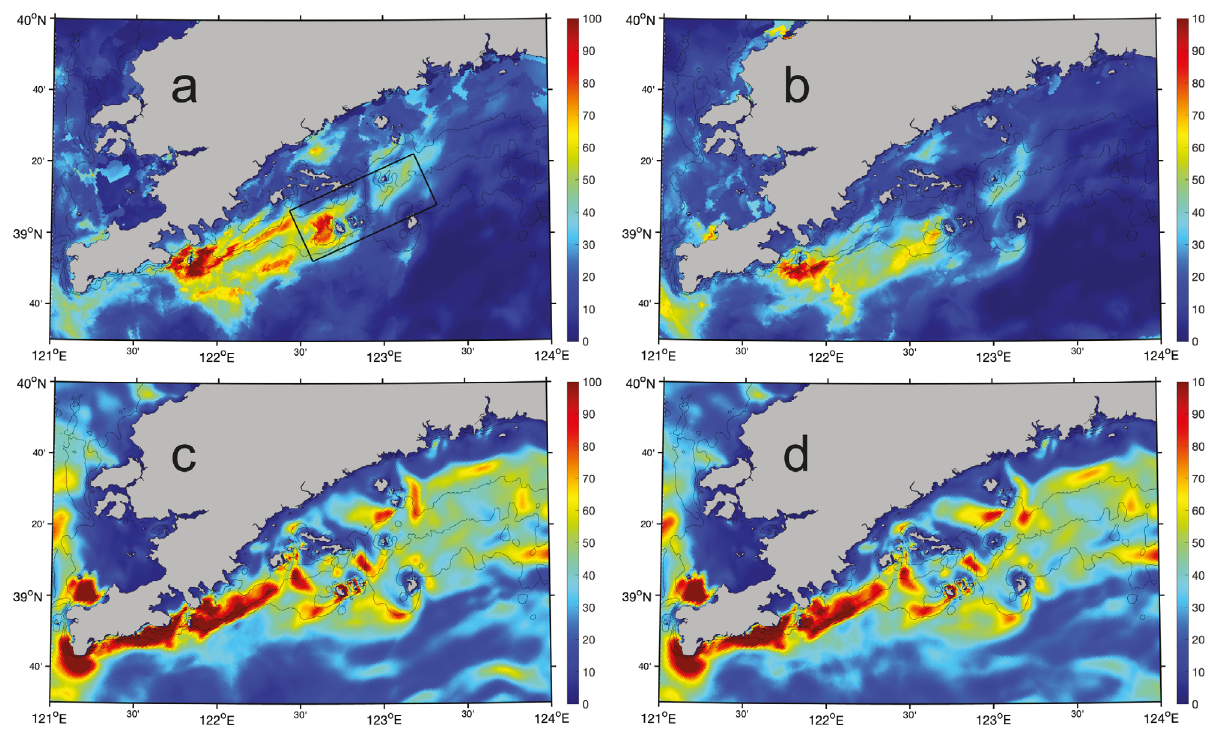
Fig. 8. Geographical distribution of the ‘dt*days’ index for the period 1 July to 30 September in (a,c) 2014 or (b,d) 2015, based on (a,b) low-passed bottom temperature time series or (c,d) original bottom temperature time series. Lines: isobaths for 20, 30 and 40 m depth; black rectangle: production area for Japanese scallops Table 1. Spatial mean values of the ‘dt*days’ index for the whole northern shelf area and scallop ranching area (in parenthesis) based on the bottom temperature low-passed time series (long period) and the pure tidal